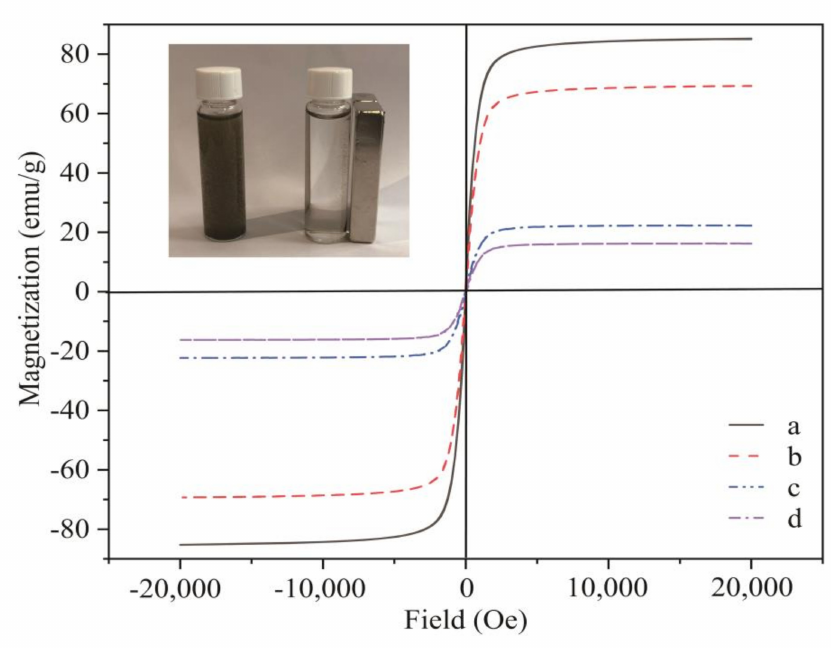
Figure 4. The magnetic hysteresis of Fe 3 O 4 ( a ), Fe 3 O 4 @SiO 2 ( b ), Fe 3 O 4 @SiO 2 / CS / GO ( c ), and Fe 3 O 4 @SiO 2 / CS / GO / β -CD ( d